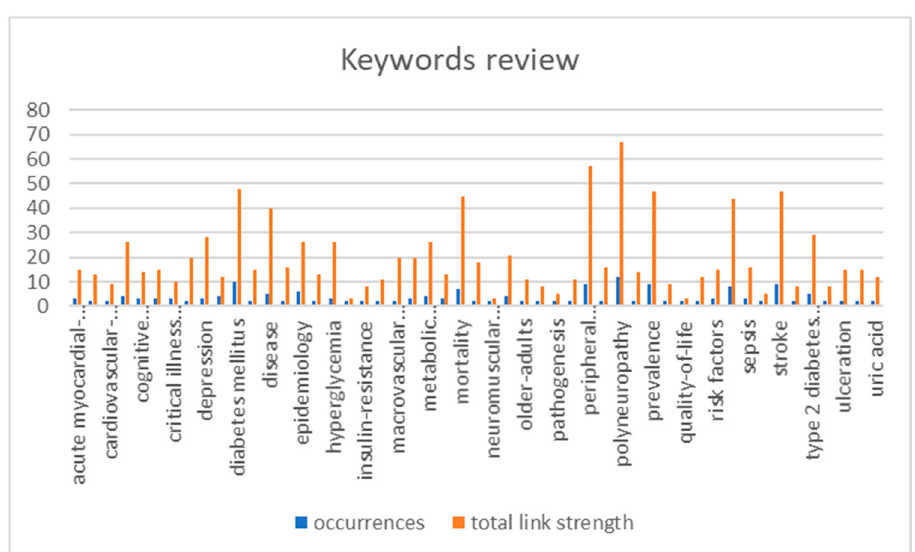
Figure 5. Keywords’ occurrence. The words that have the highest rate of occurrence are: neuropa- thy, disease, and type 2 diabetes mellitus. Epidemiology, diabetes mellitus, mortality, risk factors, peripheral neuropathy, prevalence, stroke, polyneuropathy .